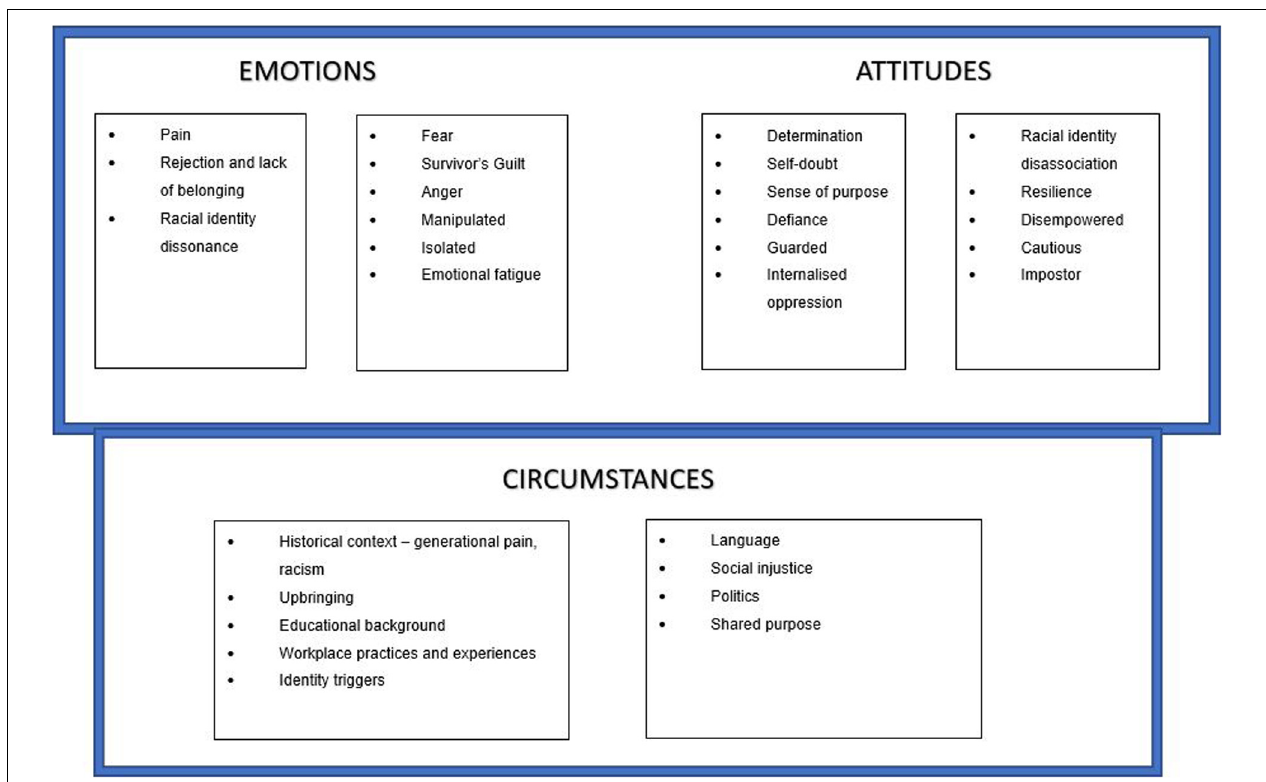
FIGURE 2 | Self-perceptions of black professionals and leaders.